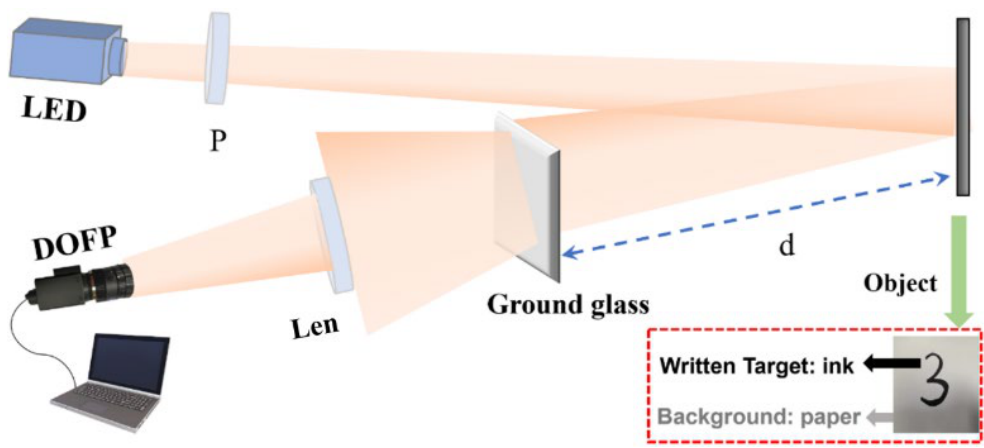
Figure 2. Schematic of the experimental setup.